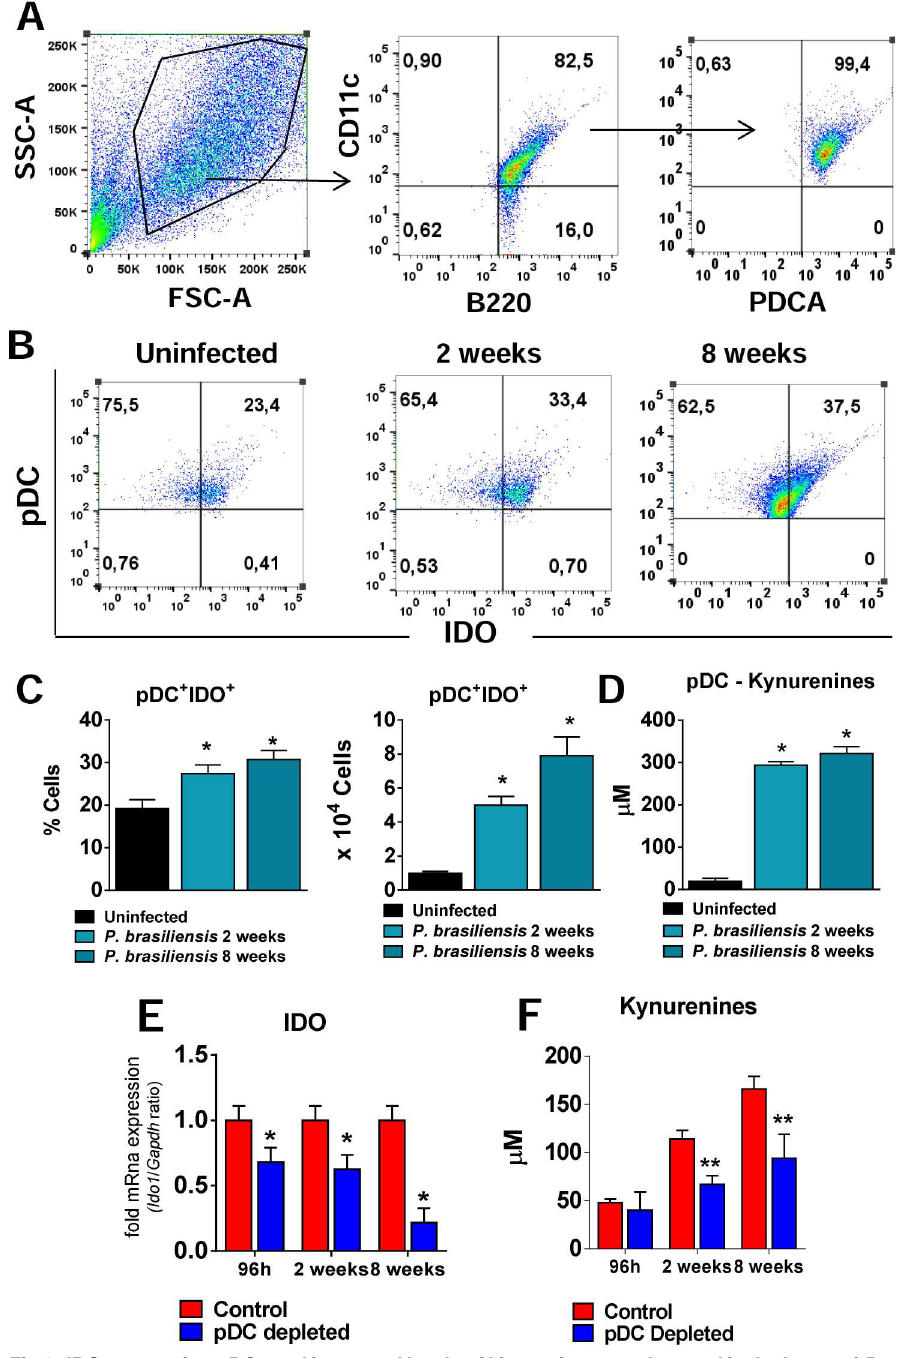
Fig 9. IDO-expressing pDCs and increased levels of kinurenines are observed in the lungs of P . brasiliensis infected mice. The presenceof pDCs expressing intracellular IDO was determined by flow cytometry in the lungsof uninfected and P . brasilienis -infectedmice (1 × 10 6 yeasts cells). At 2 and 8 week post infection the lungs wereremoved, leukocytes obtainedand the pDCs isolatedby two rounds of positive selectionas described in materialand methods. The cells werethen stained usingthe Cytofix/Cytopermkit (BD Biosciences) and specificantibodies anti-IDO. (A) The pDCs were characterized as CD11c + B220 + PDCA + cells as indicatedin the gate strategy. (B-C) Plots andbar graphicsshowingIDO-producing pDCs before andafter P . brasiliensis infection.(D) The pDCs isolatedfrom the lungswere also kept overnight in culture and the kynurenines were measuredin the supernatants.Relativeexpressionof IDO mRNA (E) and